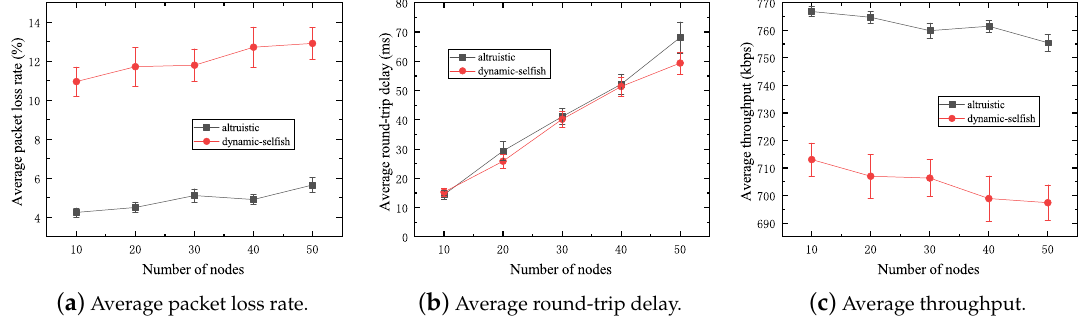
Figure 7. Performance impact of various node densities (selfish threshold: